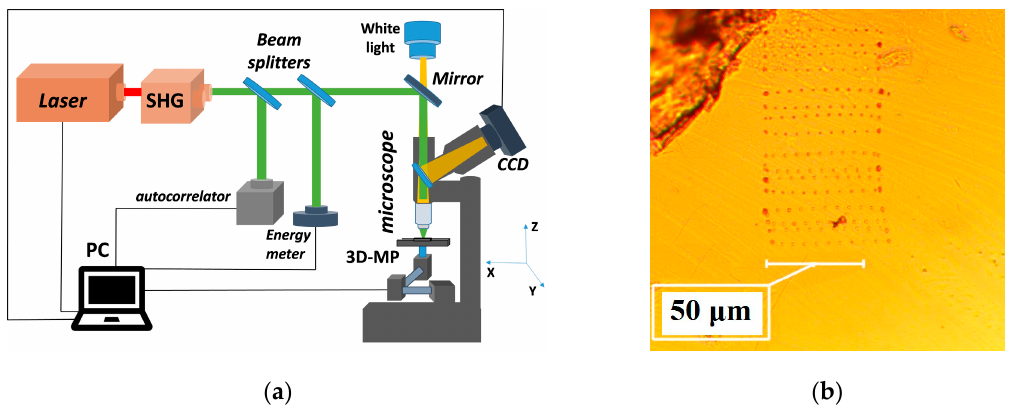
Figure 1. ( a ) Experimental setup; ( b ) Series of craters on the BaWO 4 (BWO) crystal